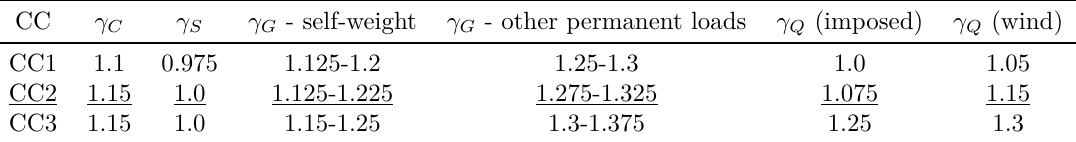
Table 3. Recommended values of partial factors for assessment of existing structures according to MC 2020.